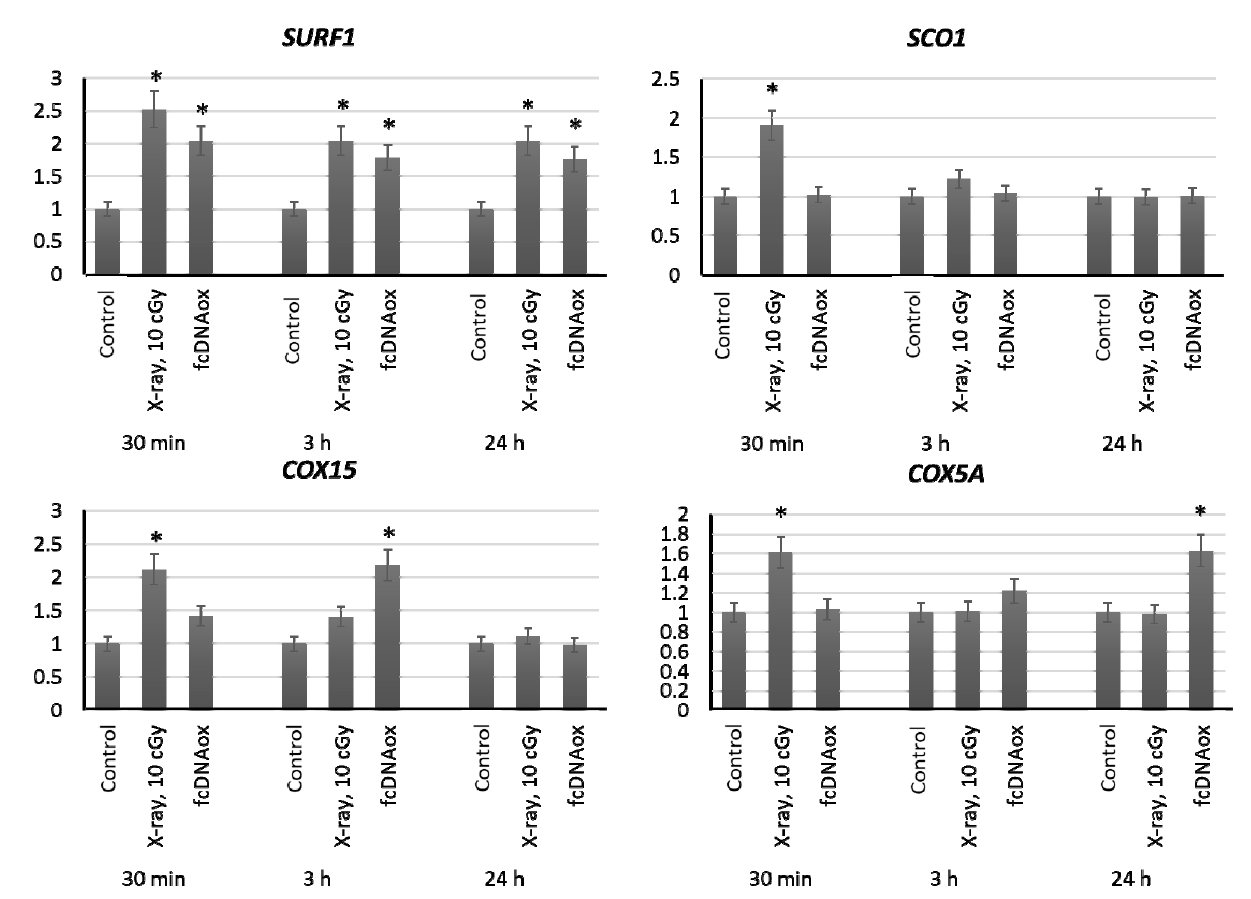
Figure 5. The expression of genes of the mitochondrial respiratory Complex IV influenced by low-dose radiation (10 cGy) and oxidized cfDNA (50 ng/mL) assessed by real-time PCR. The genes are indicated in the figure. Ratios to control values are presented. The TBP gene was used as an internal standard gene. Mean values were calculated from five independent measurements; (*) denotes a significant difference from control experiments, p < 0.001, nonparametric U-test.